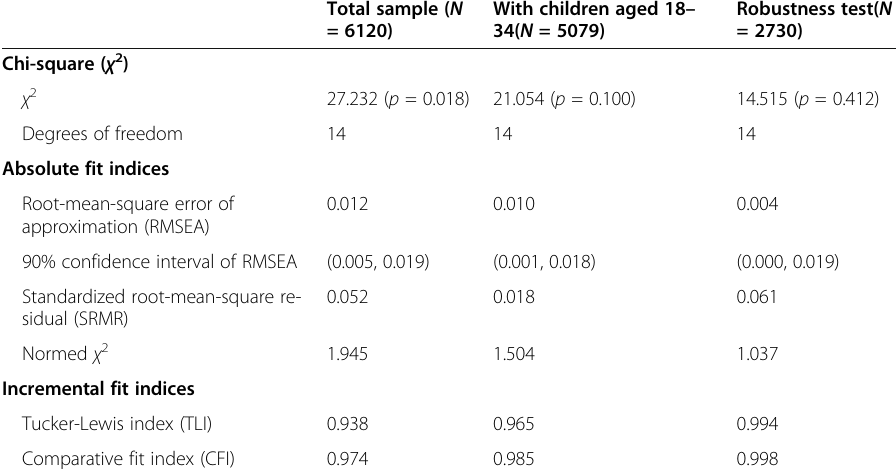
Table 2 Goodness of fit indices of the models